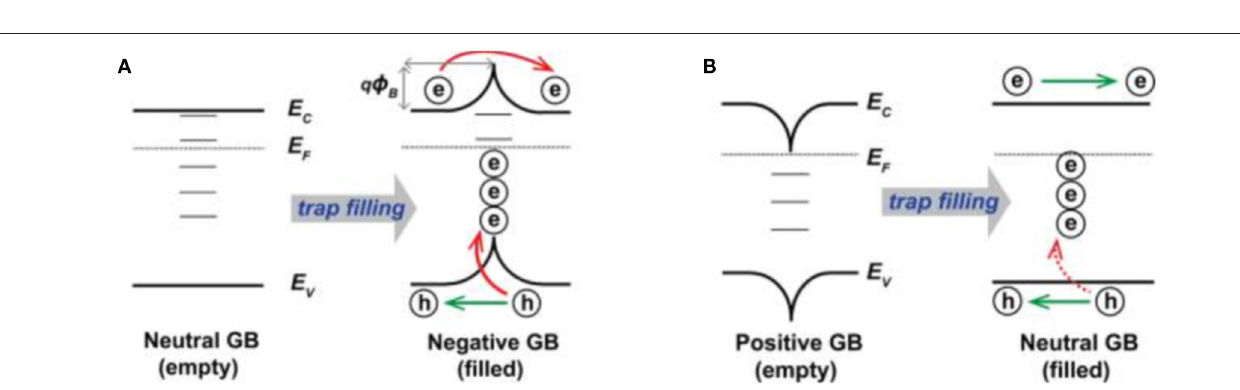
FIGURE 8 | Schematic of trap state behaviors at the grain boundary in (A) typical inorganic (poly-Si, CdTe) and (B) OHP-based solar-cells. [Reprinted with permission from Sherkar et al.